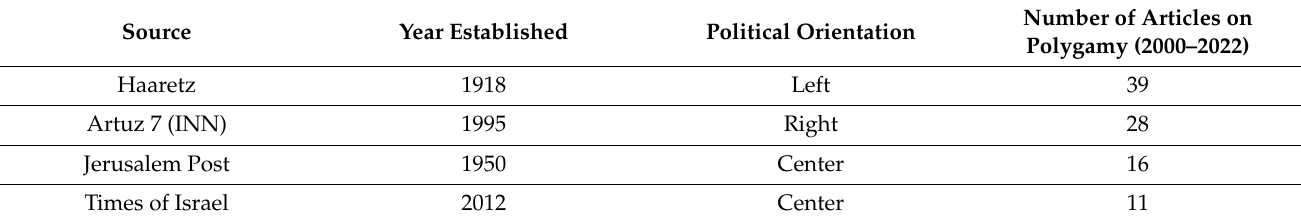
Table 1. Details on